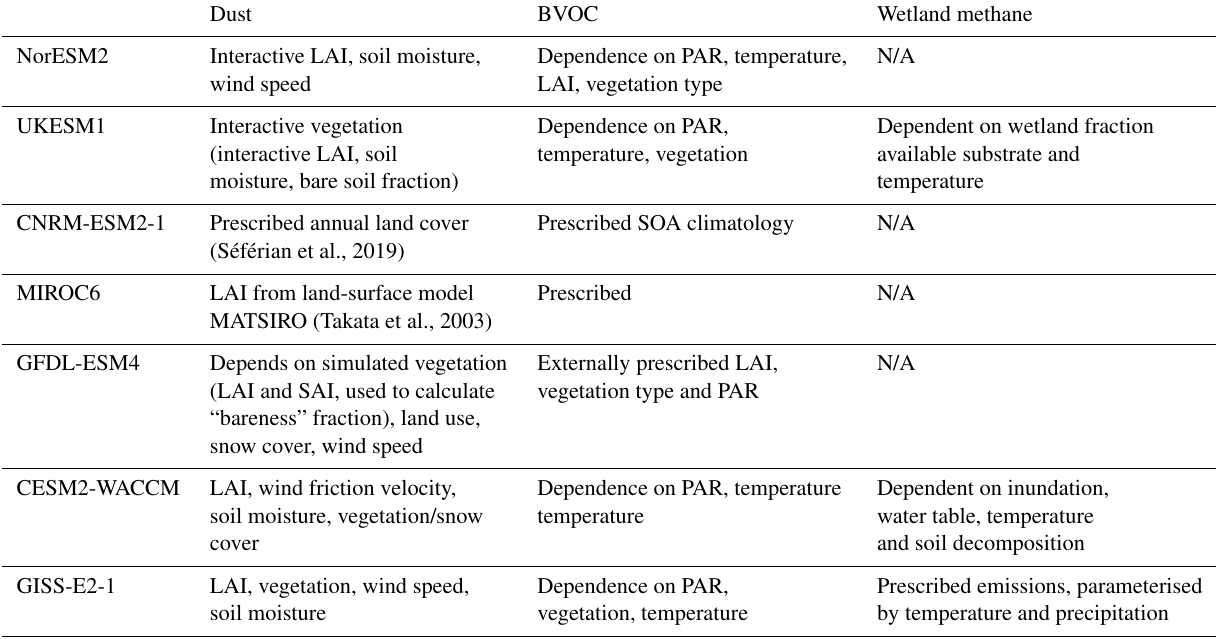
Table 3. Levels of complexity of vegetation included in the land-based emissions schemes of dust and BVOCs for the ESMs, including dependence on photosynthetically active radiation (PAR) and leaf area index (LAI).